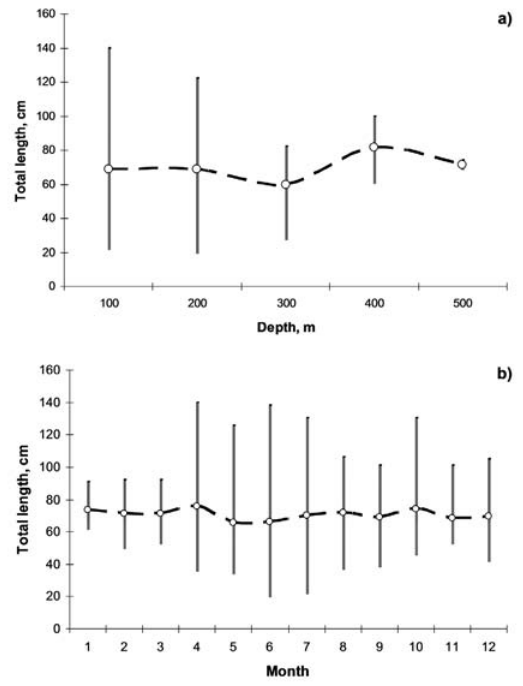
Fig . 8. – Bathymetric (a) and seasonal (b) changes of Squalus suck- leyi sizes in the North Pacific (open circles - mean values, dashed line - trend, vertical bars -